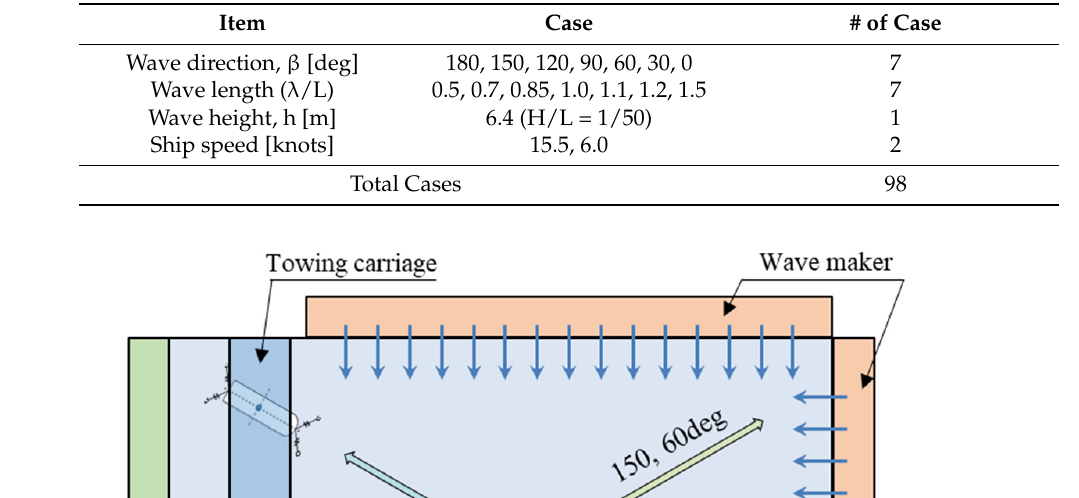
Table 2. Test cases of model test.